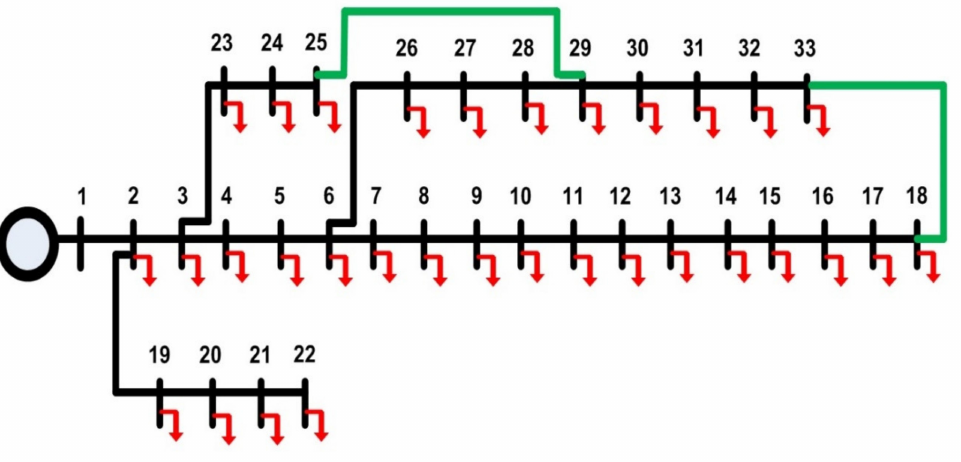
Figure 3. IEEE 33-bus interconnected test distribution network